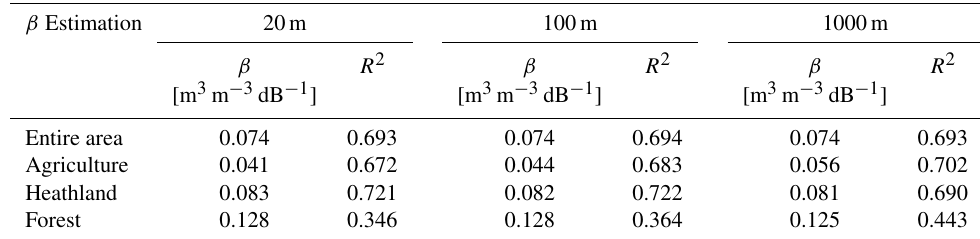
Figure 7. Zoom-in of the agricultural field site Voulund at a resolution of 20m. (a) Orthophoto (GeoDanmark data, 2018), (b) land use map (aggregated based on Levin et al., 2017) and (e)–(g) cluster maps at 20, 100 and 1000m spatial resolution. (l–o) Spatial pattern of Sentinel-1 backscatter in VV, VH, at single dates during the year 2018 as well as the respective mean and standard deviation of the entire period (h–k) and (c) VV/VH and (d) VH/VV. Red circle indicates the location of the CRNS station at Voulund. Table 3. Results of β ( θ vs VV) estimation at spatial resolutions of 20, 100 and 1000m, shown for the β invariant in space (entire area) or the β variant in space according to the three